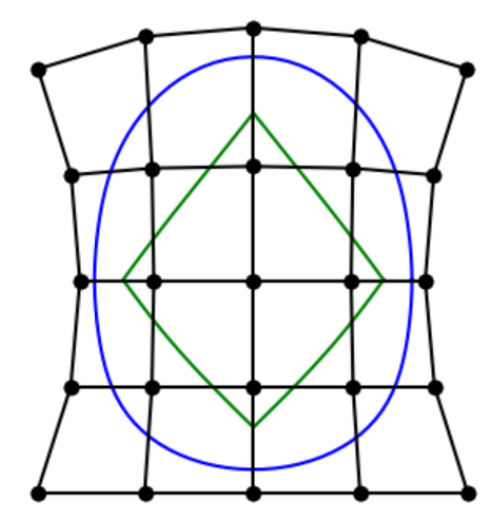
Fig. 5 Local deformation of FFD